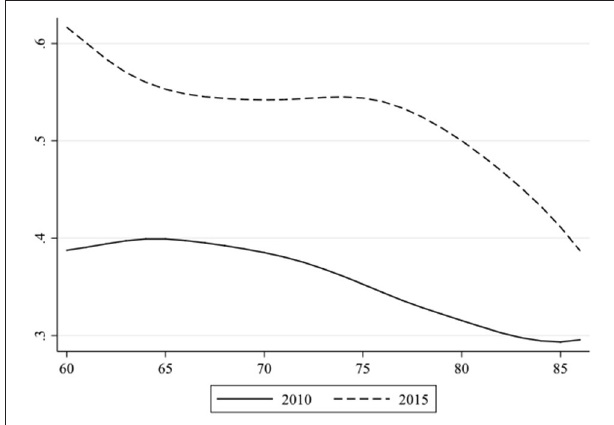
FIGURE 1 | Coefficients of educational attainment on self-rated health at every age by survey year.